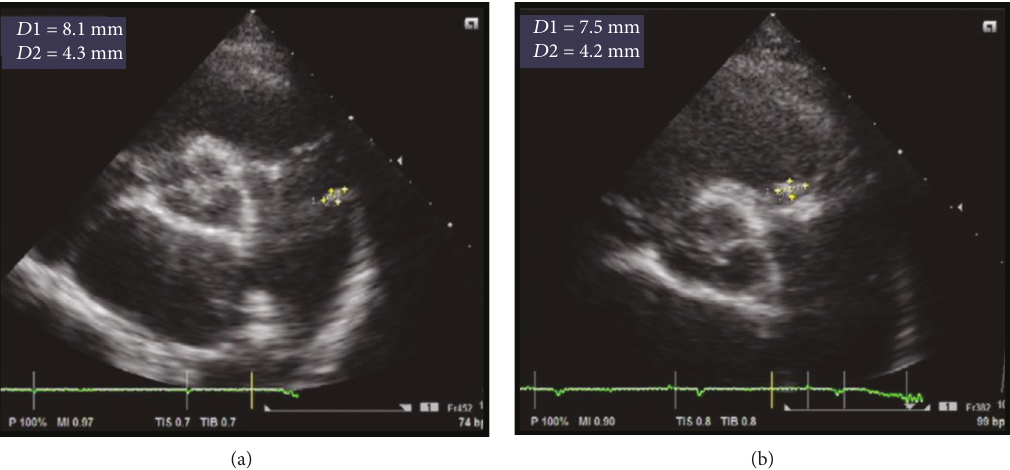
Figure 2: In the short axis view at the level of the aortic valve, there are mobile echogenic vegetations attached to the pulmonary artery (a) measuring 8 1 × 4 3 mm and on the pulmonic valve (b) measuring 7 5 × 4 2 mm